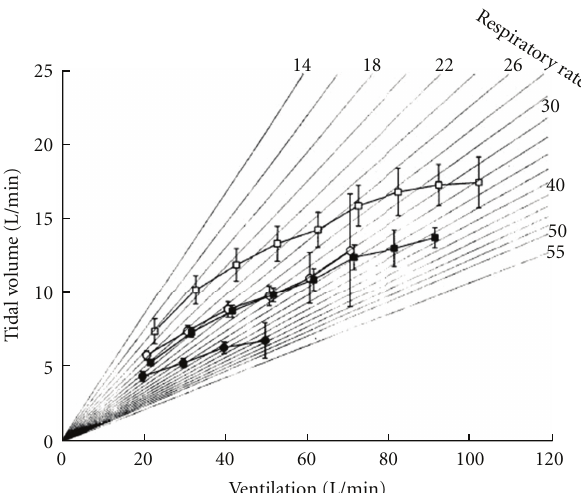
Figure 2: Tidal volume versus ventilation in patients with severe heart failure (peak VO 2 < 12 mL/min/kg, black circles), moderate to severe heart failure (peak VO 2 12–16 mL/min/kg, black squares), moderate (peak VO 2 > 16mL/min/kg, empty circles), and normal subjects (empty squares). From [5]. Reproduced with